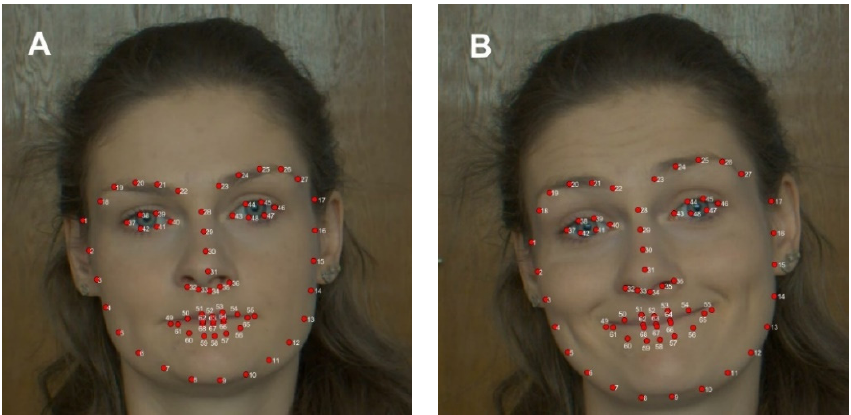
Figure 3. Key points detected in images of the same person’s face with different facial expressions: natural facial expression— A , smile— B .